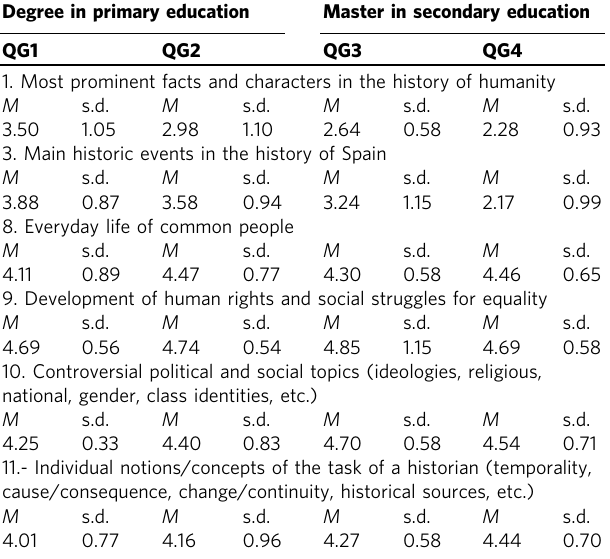
Table 4 Descriptive statistics regarding the role of the teacher in history class (Section II).